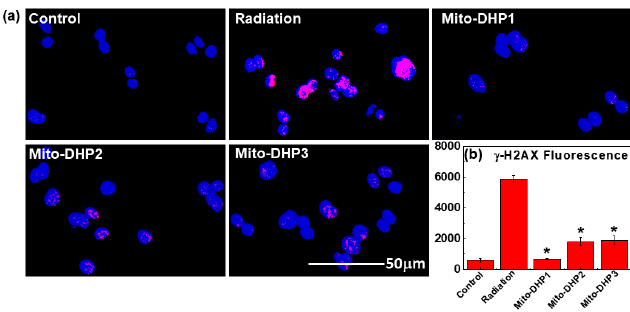
Figure 3. Determination of phosphorylated histone H2AX ( γ -H2AX) in CHO-K1 cells at 1 h after γ radiation. ( a ) Images of cells obtained during the immunofluorescence assay showed γ -H2AX foci in different treatment groups; ( b ) γ -H2AX foci fluorescence of control, radiation and Mito-DHPs treated groups after 3 Gy radiation. (* p < 0.05 compared with radiation group).